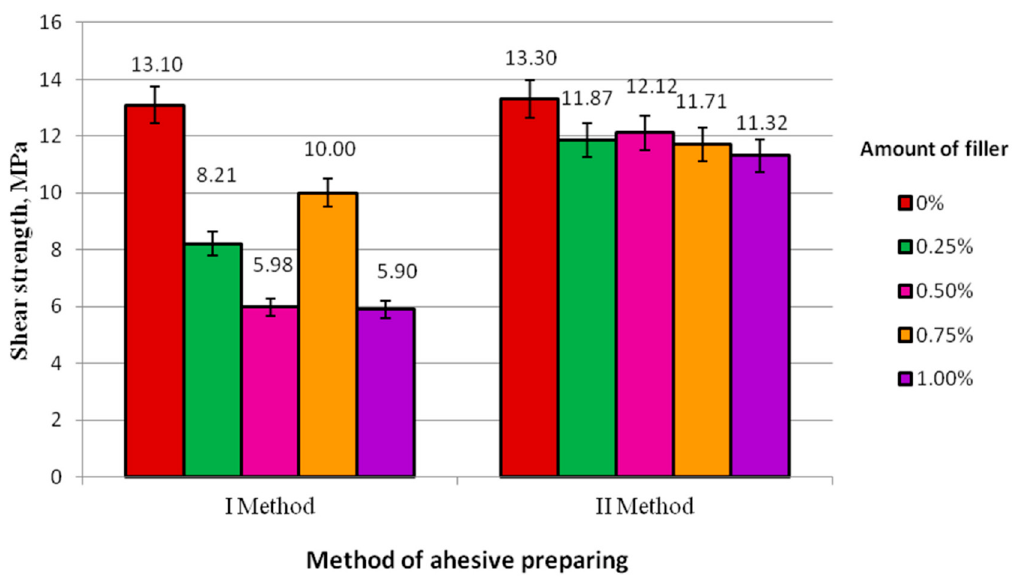
Figure 2. Shear strength of adhesive joints produced according to Methods I and II.